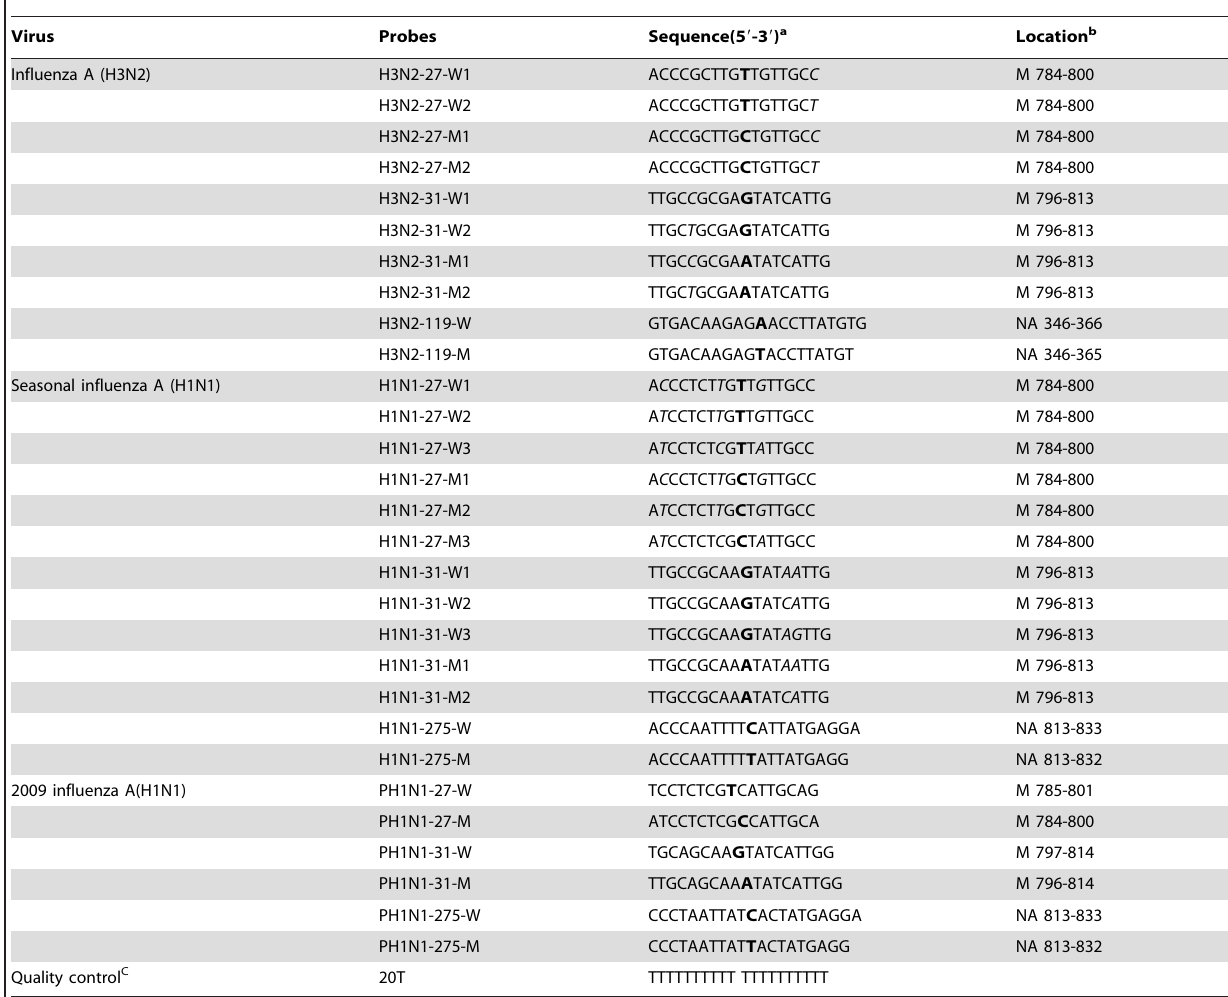
Table 2. The probes sequences for microarray.